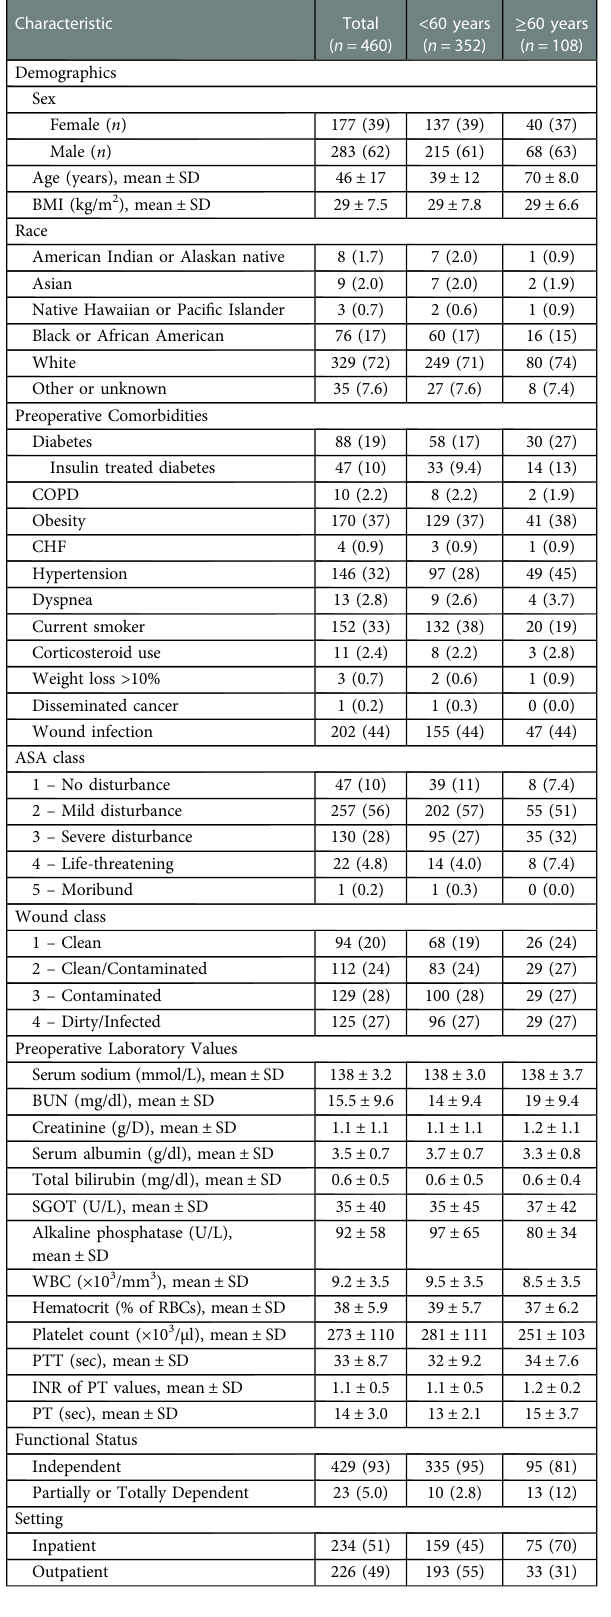
TABLE 1 Patient demographics and comorbidities. Reported as n (%). TABLE 2 Types of burn injury and type-speci fi c occurrence of any complication. Reported as n (%).